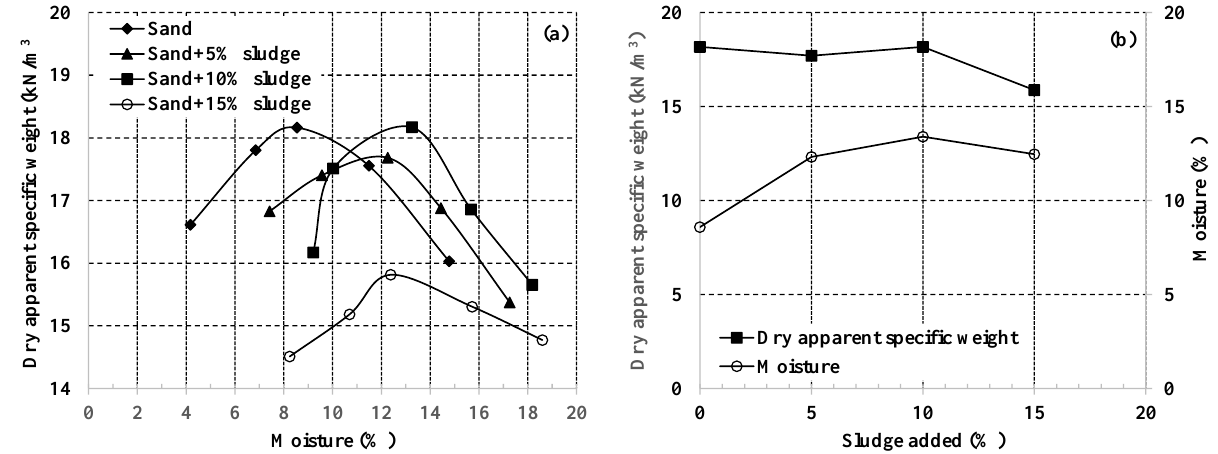
Figure 5. ( a ) Compaction curves of the tested materials and ( b ) Percent sludge versus maximum apparent dry specific weight and versus optimum moisture content.